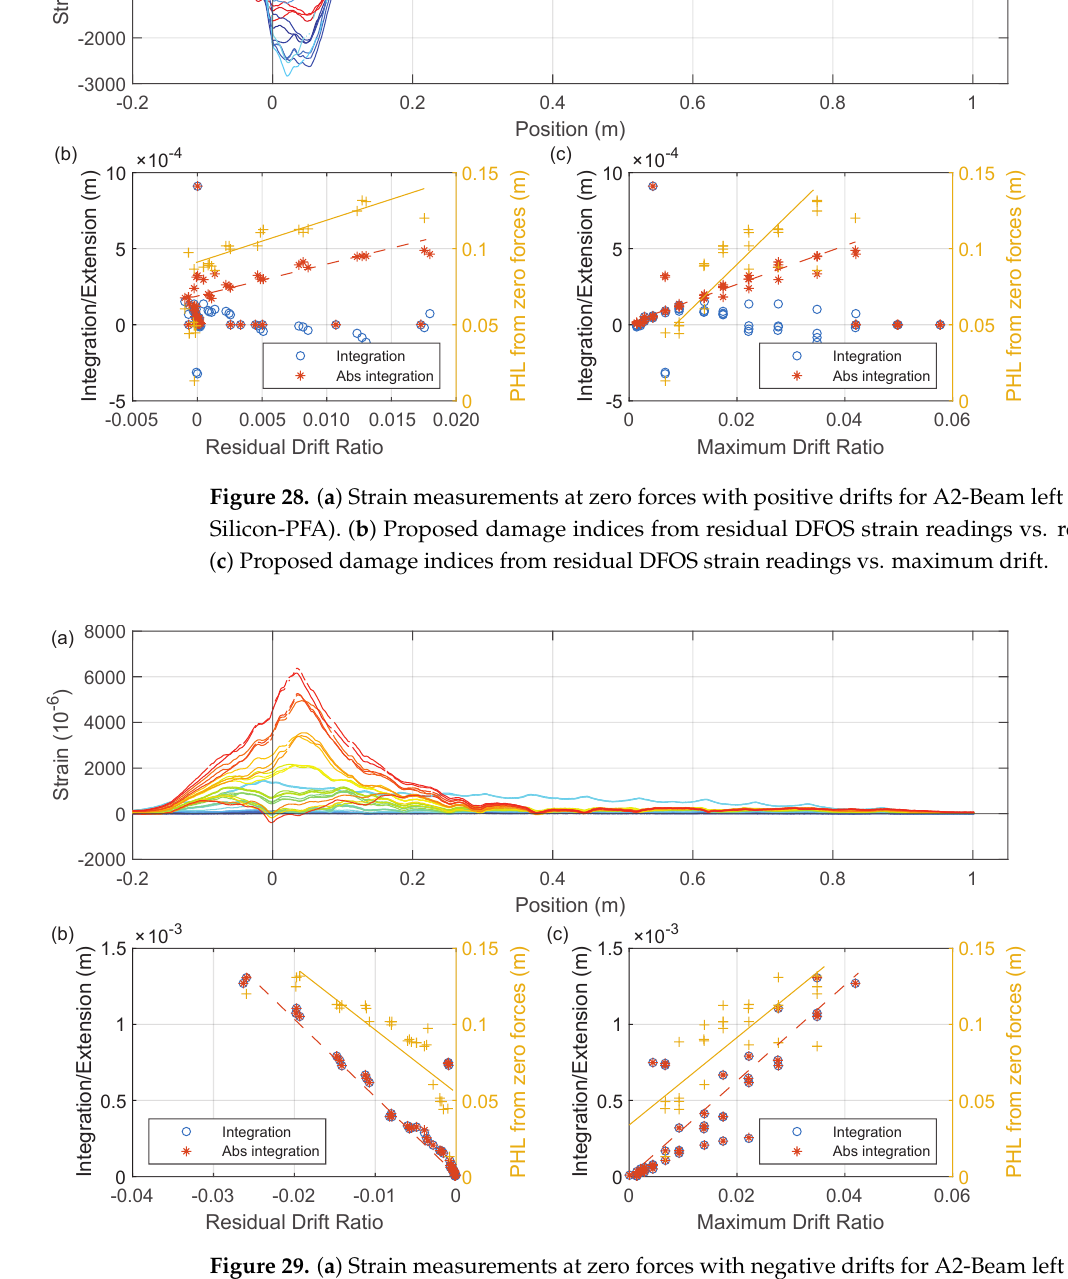
Figure 29. ( a ) Strain measurements at zero forces with negative drifts for A2-Beam left (down to up Silicon-PFA). ( b ) Proposed damage indices from residual DFOS strain readings vs. residual drift. ( c ) Proposed damage indices from residual DFOS strain readings vs. maximum